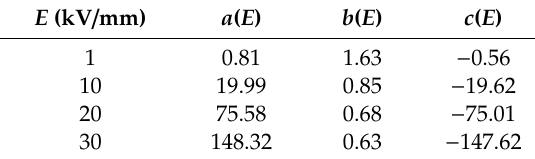
Table 3. Values of the parameters in Equation (12) under di ff erent electric field